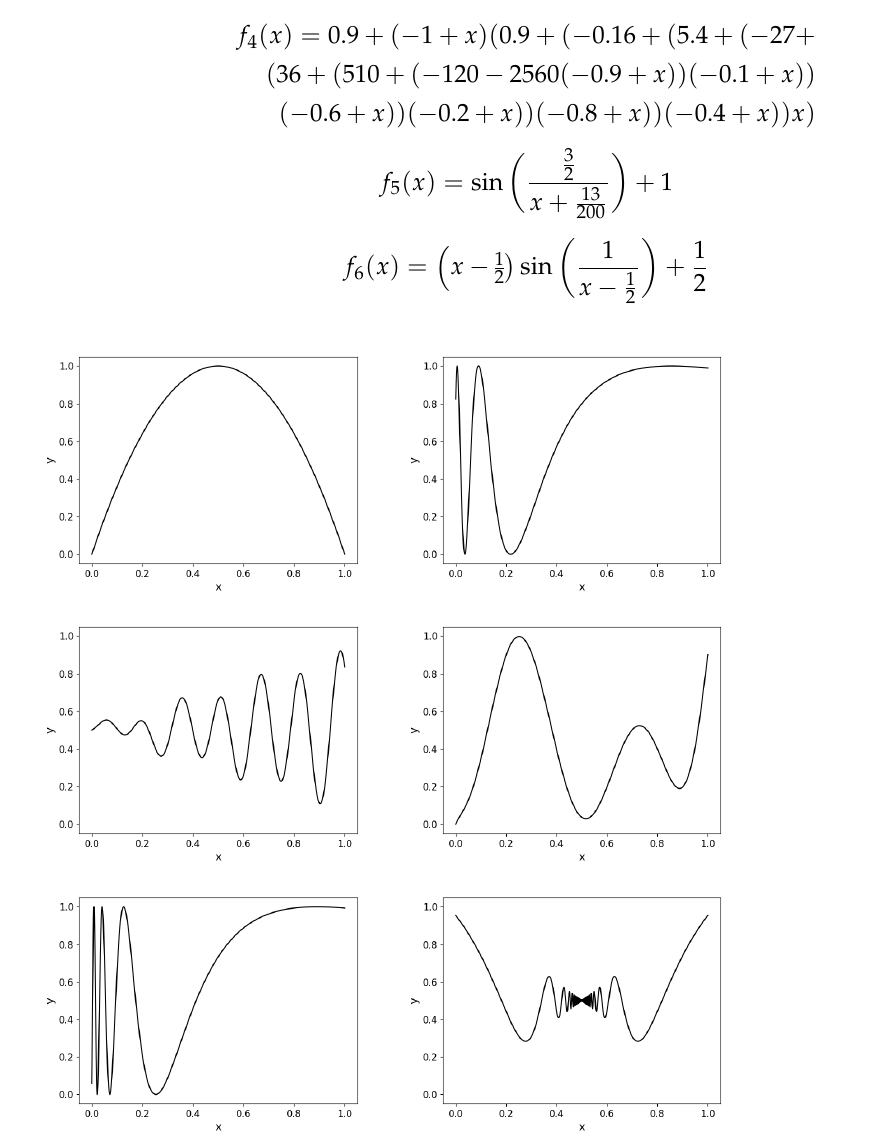
Figure 1. Graphs of the functions f 1 , f 2 , f 3 , f 4 , f 5 , and f 6